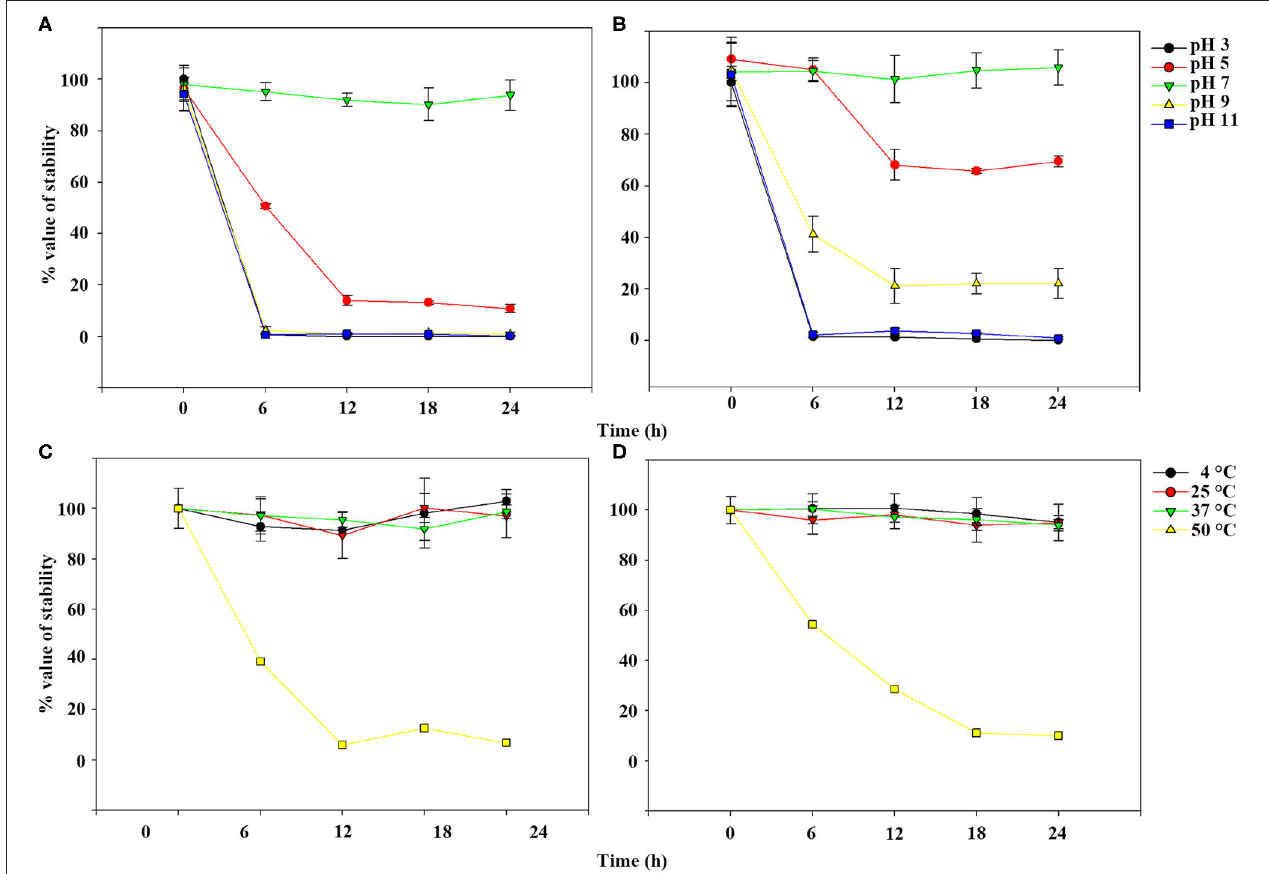
FIGURE 3 | Phage stability of pSp-J and pSp-S at different pH [pSp-J (A) and pSp-S (B) ] and temperature (pSp-J (C) and pSp-S (D) ] conditions. Phages were incubated for 24h under each condition and the phage titer was determined on the host strain at 6h intervals. Values are presented as the mean ± standard deviation.